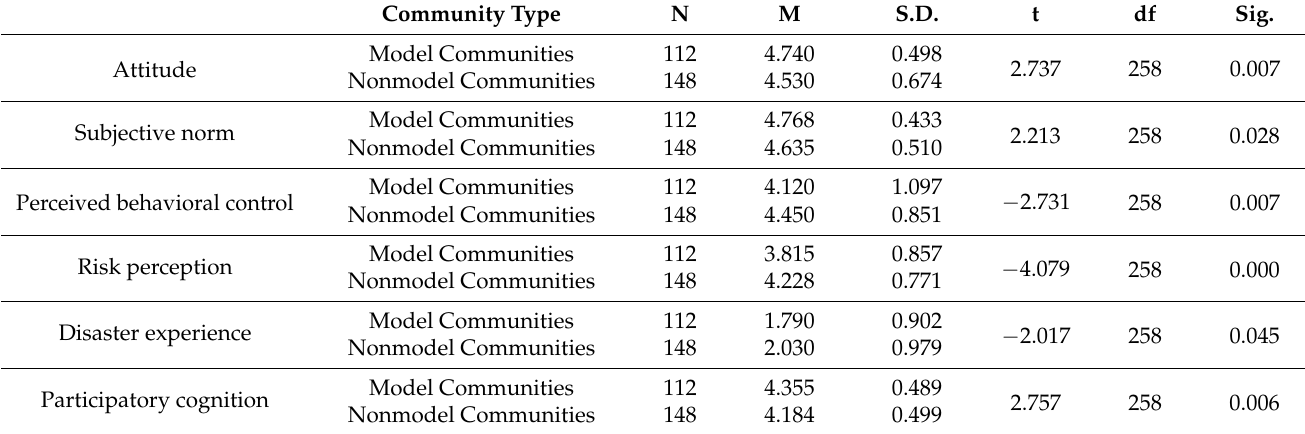
Table 3. Levels of the variability of impact factors between different community